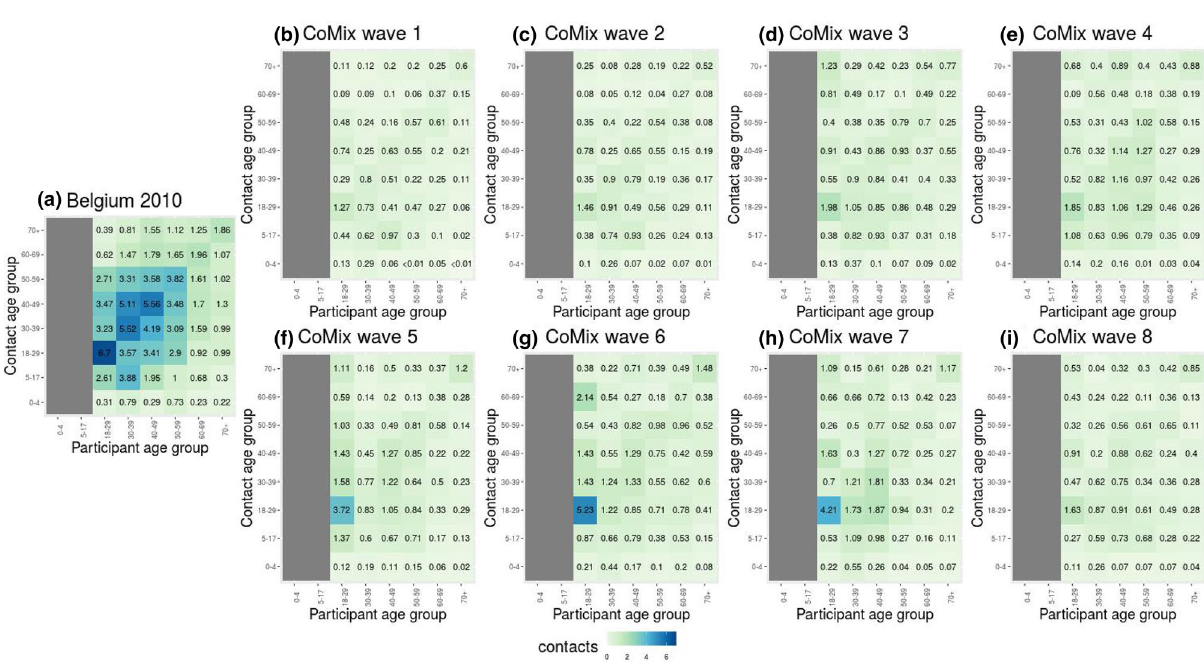
Figure 3. Social contact matrices. ( a ): Average number of daily reported contacts for the 2010 survey. ( b – i ) Average number of daily reported contacts for the 8 waves of the CoMix survey. The columns corresponding to participants below 18 years of age in the 2010 data have been removed, to ease the comparison with the CoMix data.